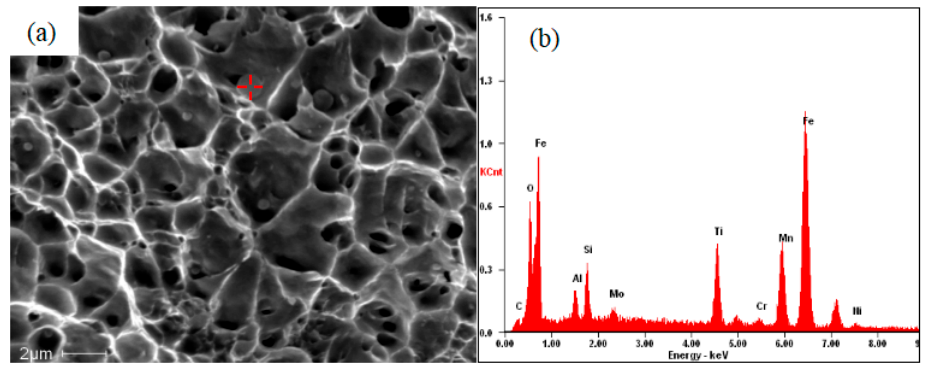
Figure 20. The distribution of particles and their EDX analysis: ( a ) distribution of second phase particles; ( b ) the EDX analysis.